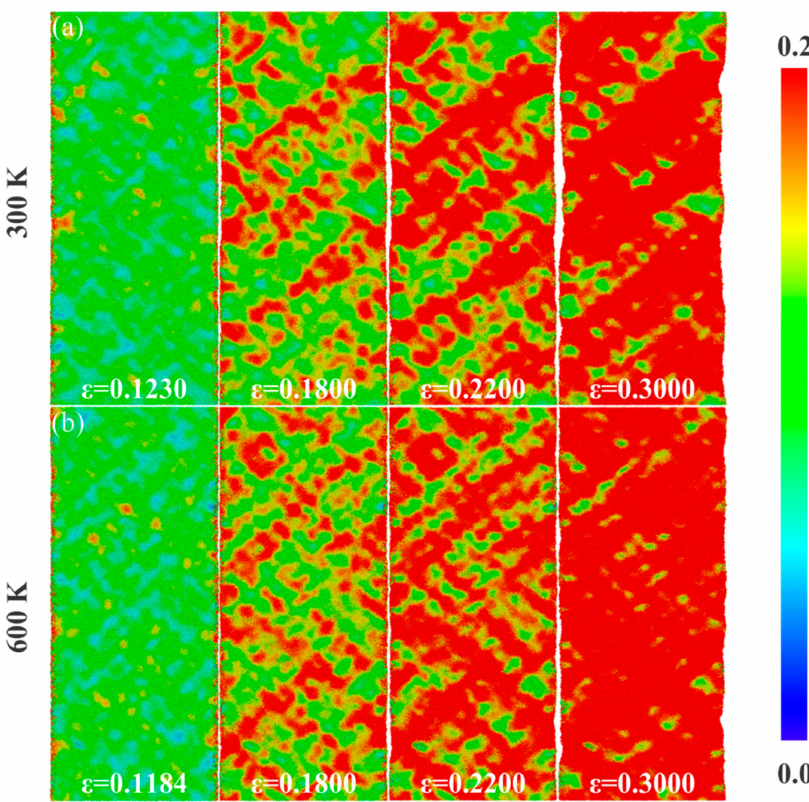
Figure 9. Evolution of von-Mises strain for ng-AlN d = 1 nm at di ff erent strain levels at ( a ) 300 K and ( b ) 600 K, respectively.